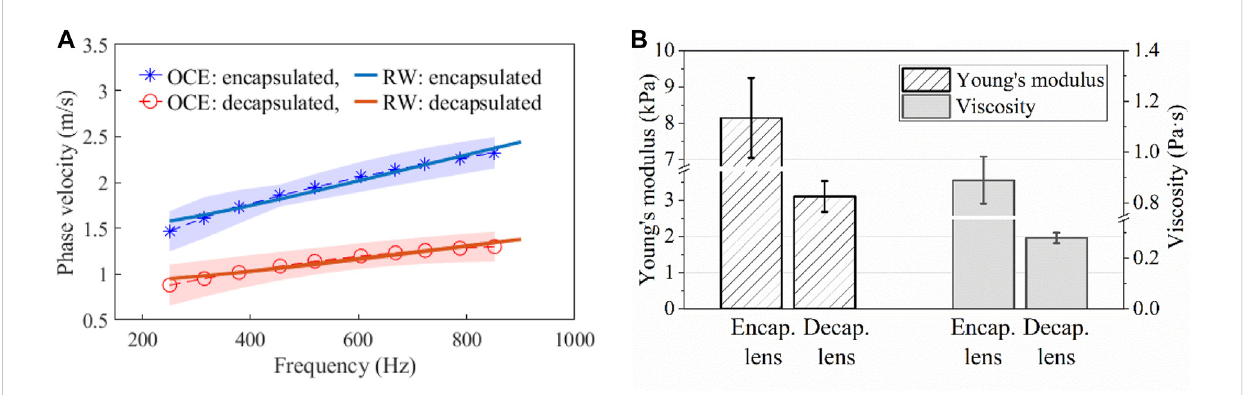
FIGURE 4 (A) Typical elastic wave dispersion curves in the porcine lens before and after capsule removal fi tted with Rayleigh wave dispersion equation. The shaded region indicates the error band (standard deviation) of the OCE results. (B) Estimated Young ’ s modulus and viscosity coef fi cient using Rayleigh wave dispersion equation for encapsulated and decapsulated lens. N = 8 porcine eye